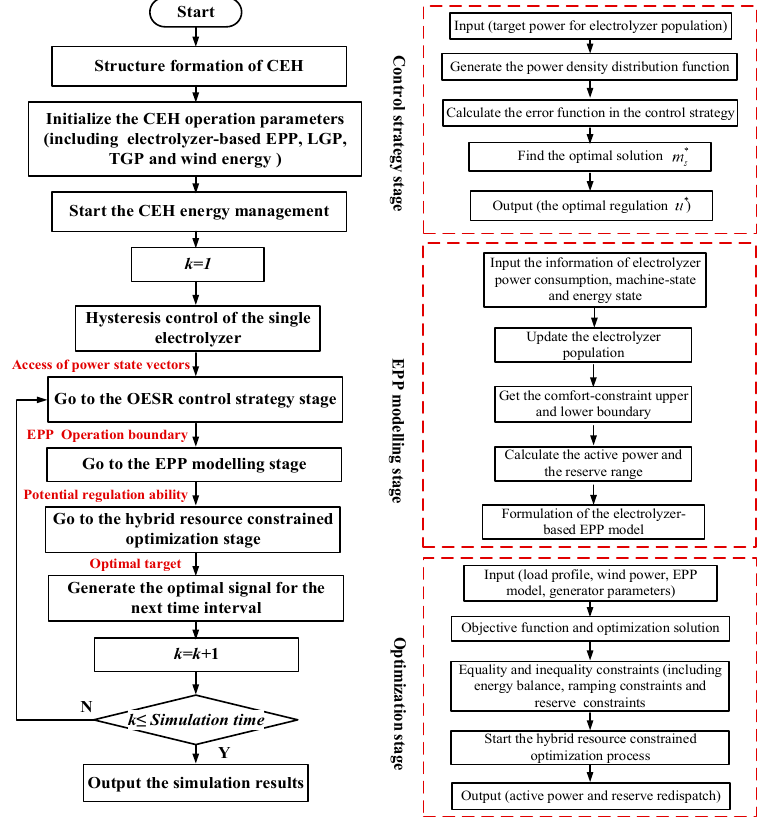
Figure 5. Flow chart of energy management of the CEH.